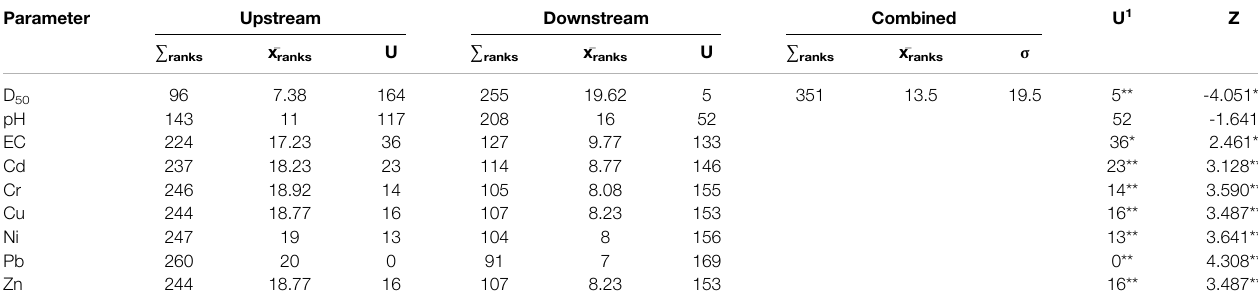
TABLE 4 | Summary of the results of the Mann – Whitney U test for the tested parameters between the sections upstream and downstream of the hydropower plant on the Bystrzyca river. Parameter Upstream Downstream Combined U